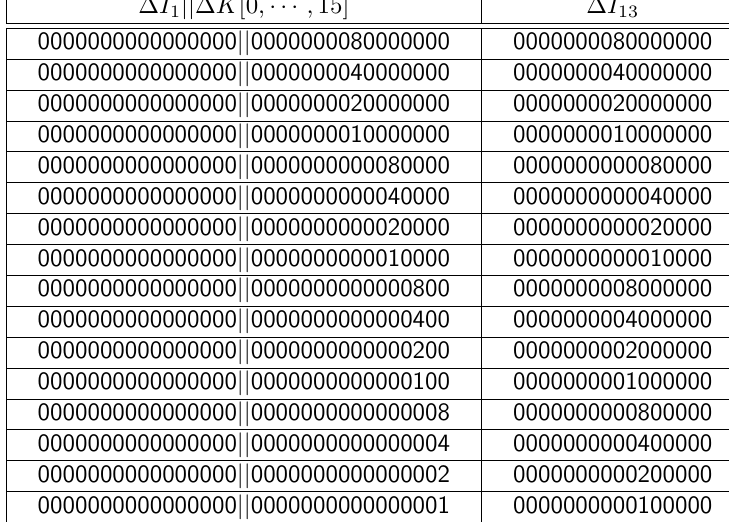
Table 5: 16 related-tweakey impossible differentials for 12-round SKINNY-64-64 (In hexadecimal